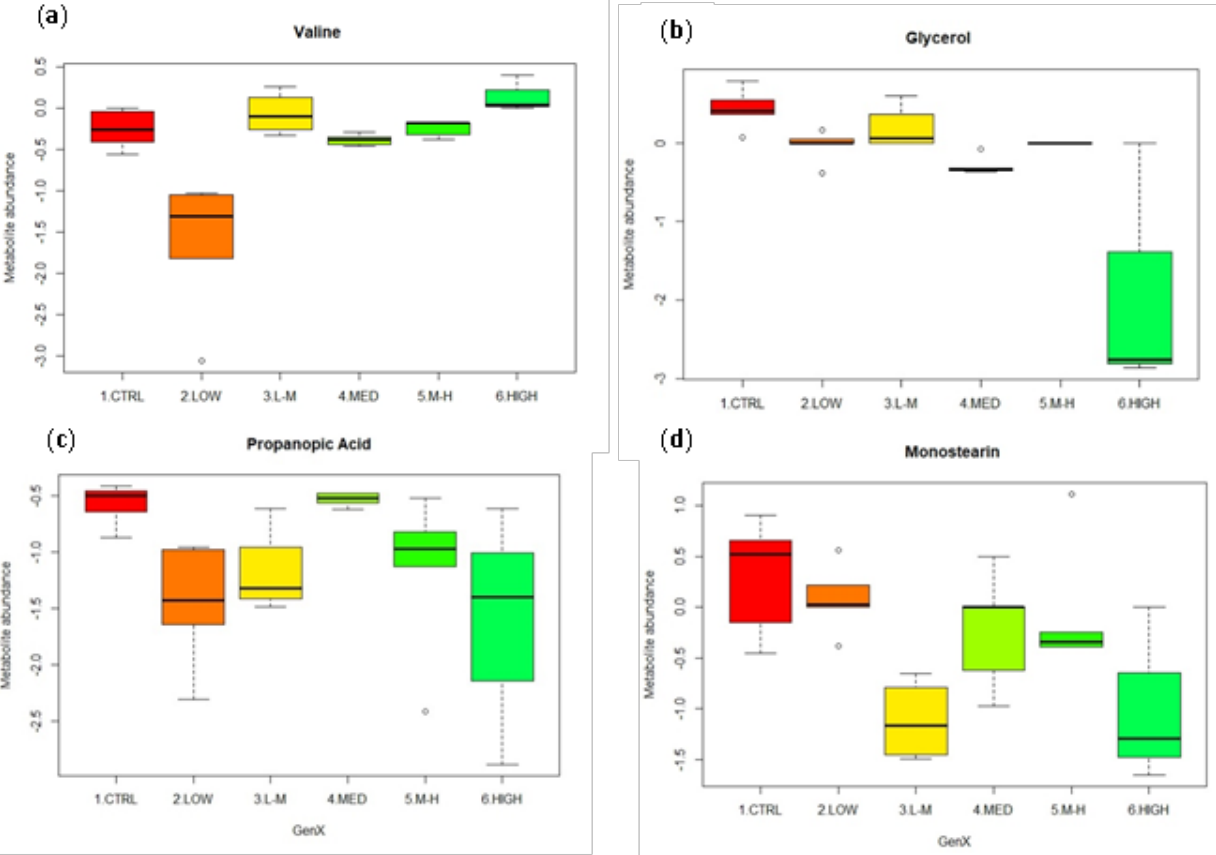
Figure 5. Significant metabolites from amphipods exposed to GenX at low (0.03 µ g/L), low–medium (0.16 µ g/L), medium (0.80 µ g/L), medium–high (4.00 µ g/L) and high (20.00 µ g/L) concentrations. ( a ) Valine; ( b ) glycerol; ( c ) propanoic acid; ( d ) monostearin.